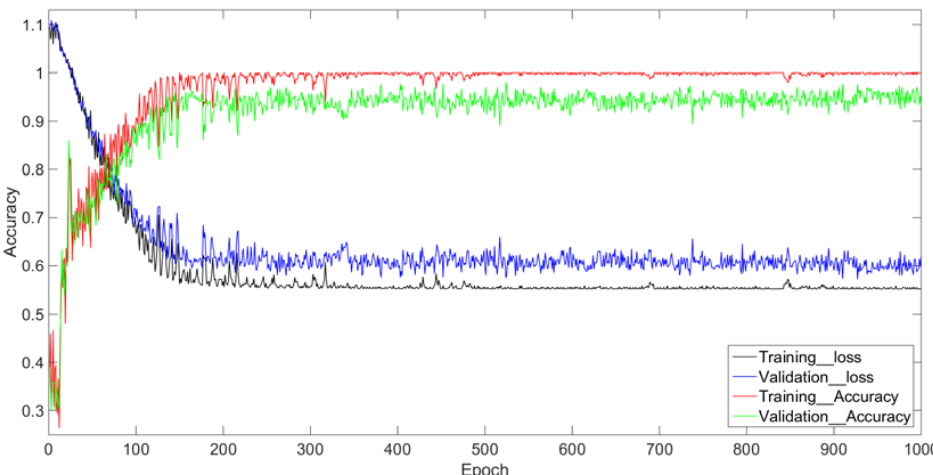
Figure 7. The recognition accuracy of this network training and testing process.